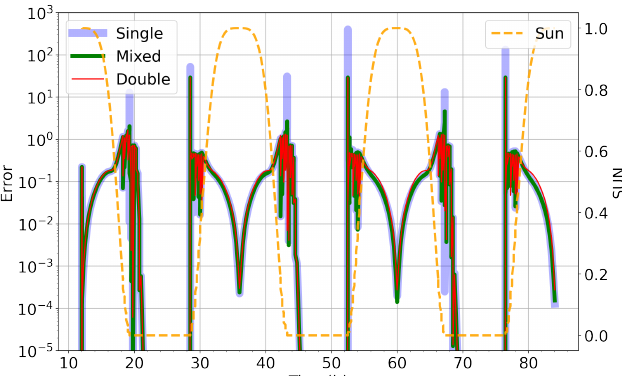
Figure 1. Total species error ( Err ) over time for small stratospheric model using Ros3 numerical solver for RelTol = 10 − 2 for out-of-the-box single precision (blue), double precision (red) and our implementation of mixed precision in KPP (green). We also show here the sunlight intensity (orange), which controls the onset, intensity and termination of atmospheric